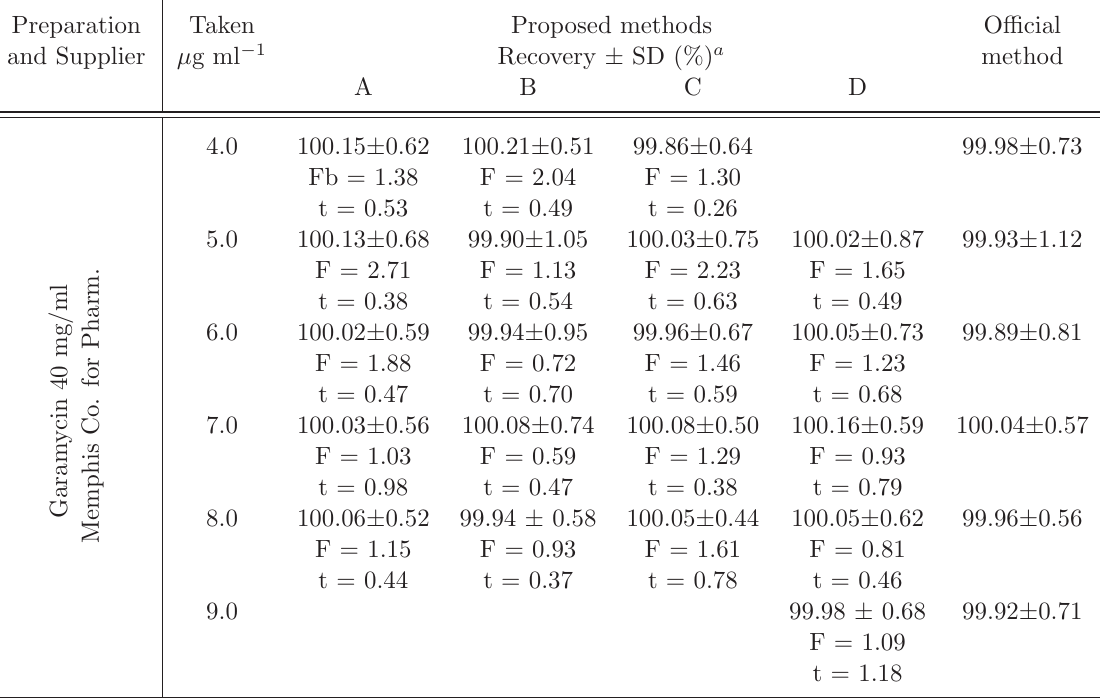
a The average of six determinations. b Theoretical values for t- and F-values for five degrees of freedom and 95% confidence limits are 2.57 and 5.05,